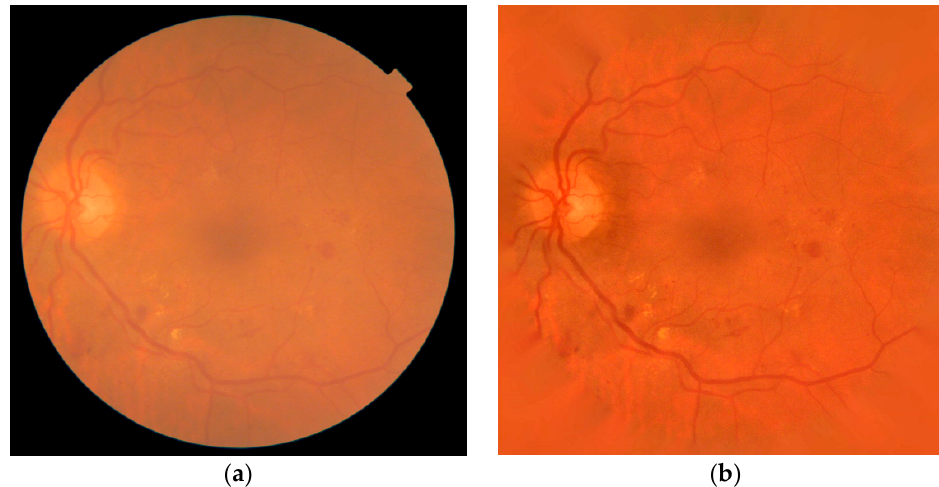
Figure 2. Preprocessing stage. ( a ) Original image. ( b ) Preprocessed image, I prep .